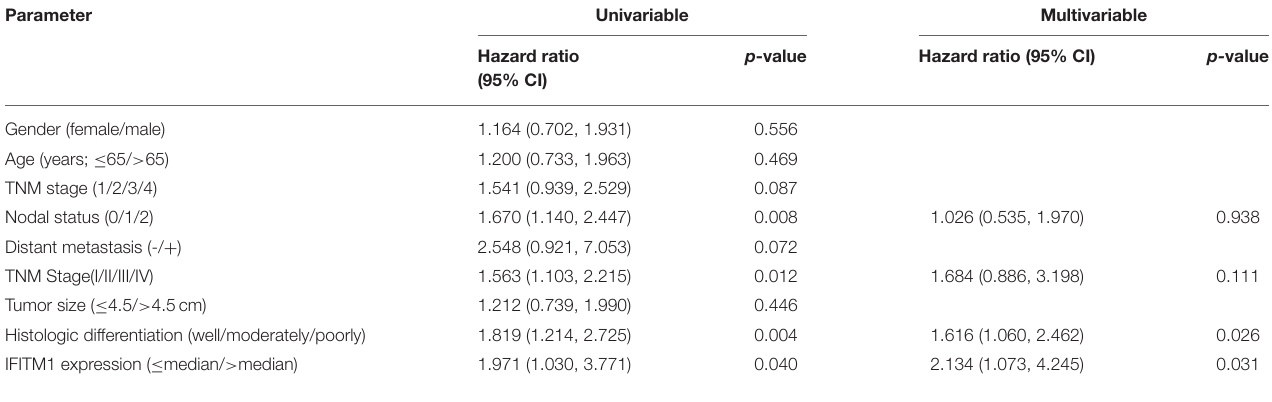
TABLE 4 | Univariable and multivariable Cox regression analyses for overall survival, accounting for IFITM1 expression and clinicopathological features in 90 patients with pancreatic cancer.